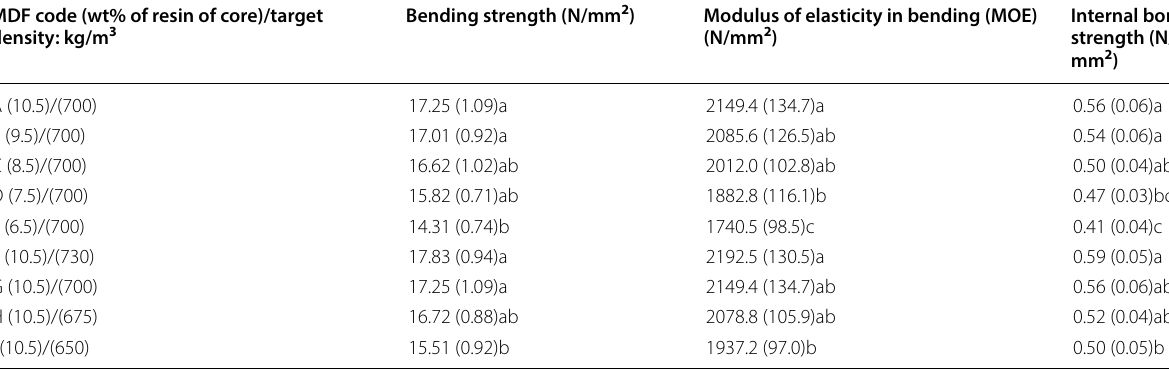
Groups with same letters (from a to c) in each column indicate that there is no statistical difference ( p < 0.05) between the specimens according to Duncan’s multiply range test